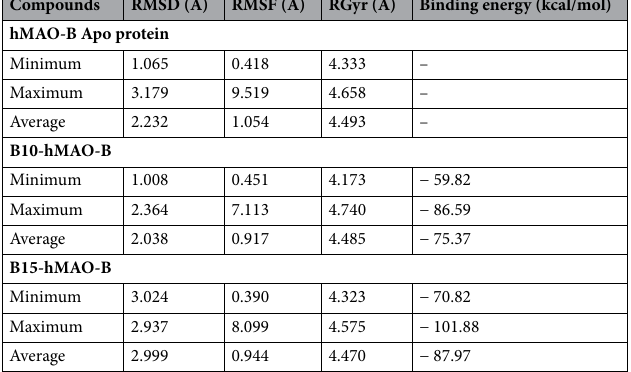
Table 4. The values of RMSD, RMSF, RGyr, and ∆G Bind for B10 - and B15